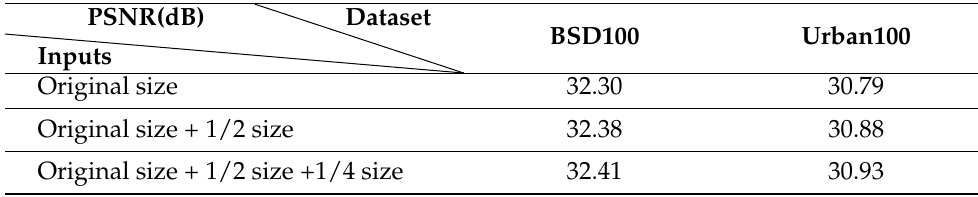
Table 1. Comparison with different sized inputs on BSD100 and Urban100.